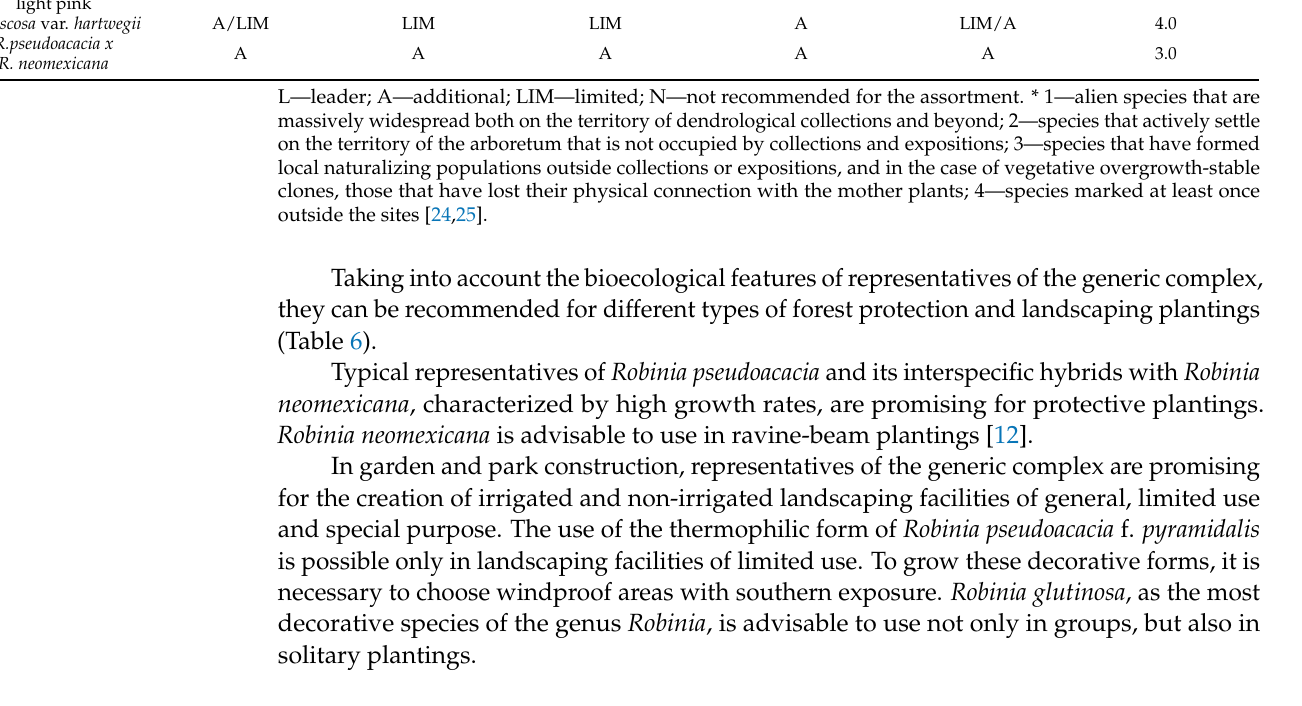
Table 6. Assortment of Robinia species and forms suitable for various types of protective afforestation and